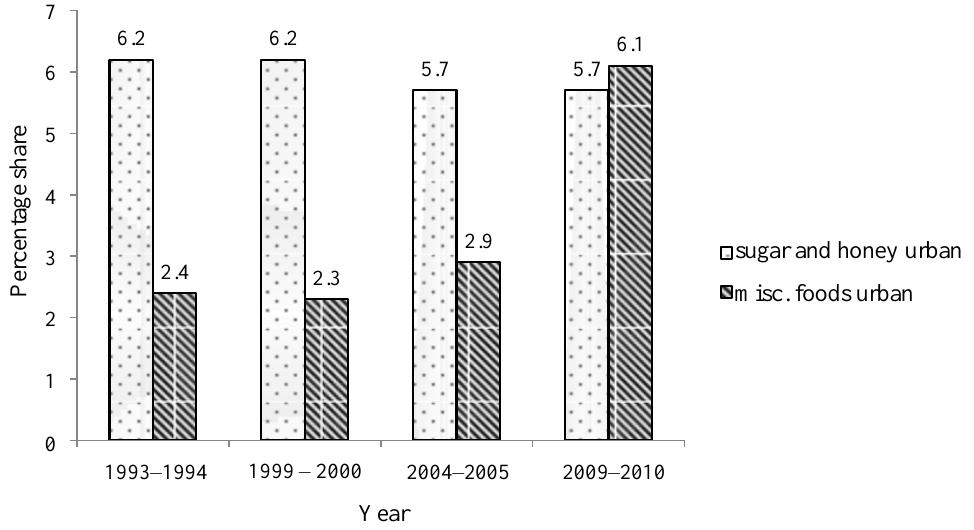
Figure 5. Percent share of total calories from “sugar and honey” and “Misc. foods” in urban population of India,